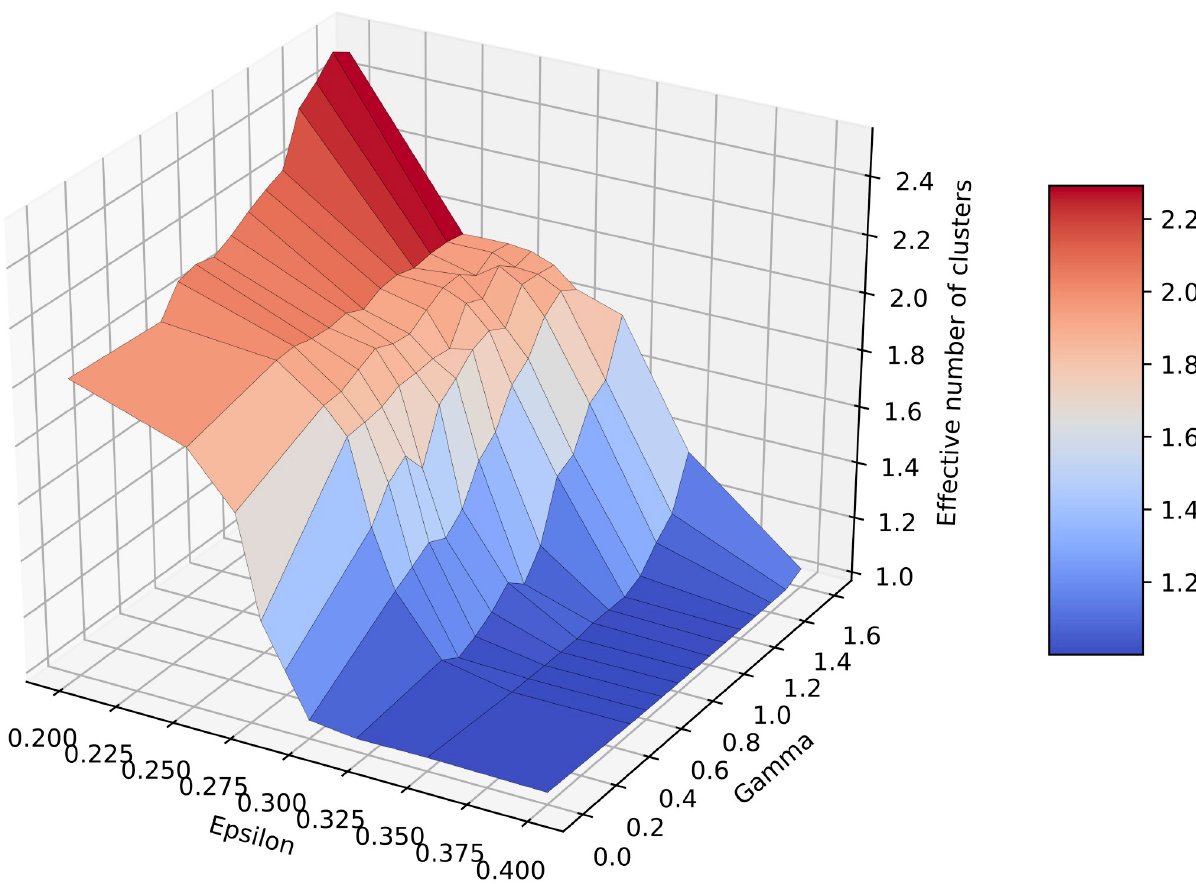
Fig 1. Number of clusters obtained for various ε and γ . For ε > 0.4 the population always converges to 1 cluster, so we omitted the range from the plot, for better visualisation. Values are averaged over 100 runs.